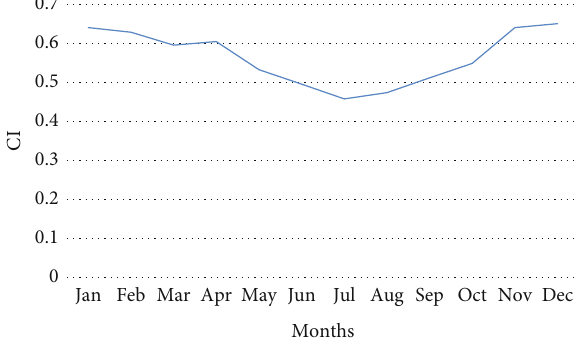
Figure 40: Monthly clearness index (CI) for South Sudan.